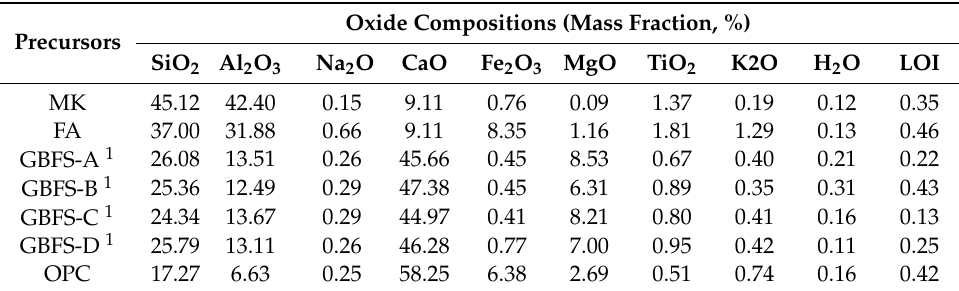
Table 1. Chemical compositions of precursors for geopolymer